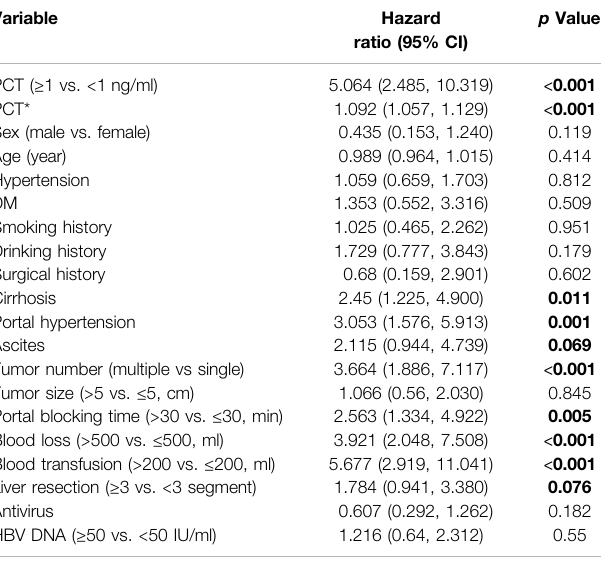
TABLE 2 | Univariate and multivariate analyses for risk factors associated with PHLF. Variable